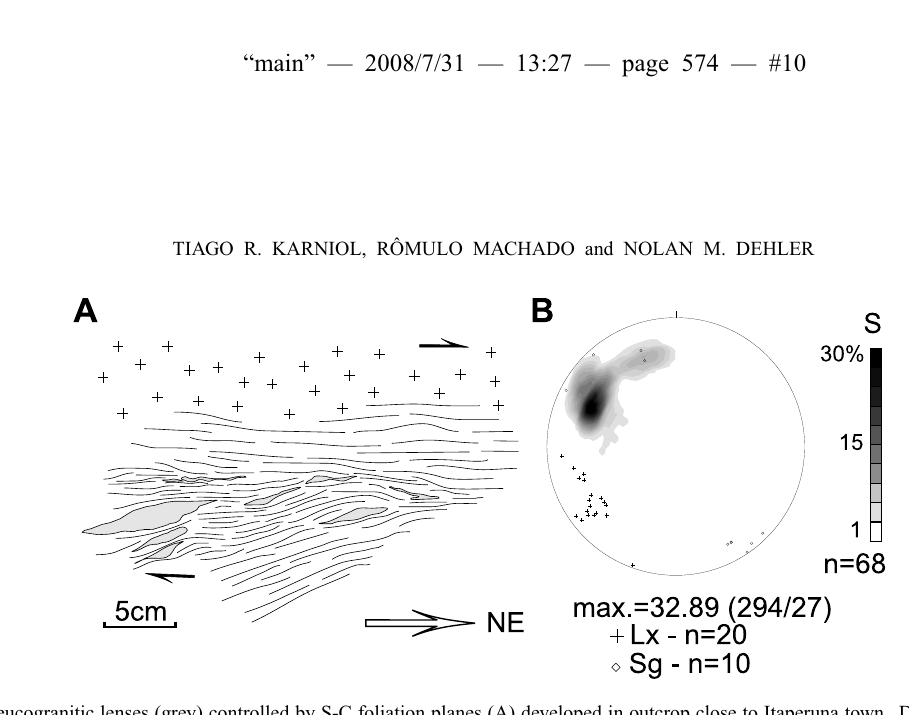
Fig. 11 – Leucogranitic lenses (grey) controlled by S-C foliation planes (A) developed in outcrop close to Itaperuna town. Dextral movements contain top-down to SW component (B), where foliation planes (S), mineral and stretching lineation (Lx) and leucogranitic (Sg) are plotted. Equal area lower hemisphere Schmidt-Lambert stereographic projection. Number of data (n) shown.